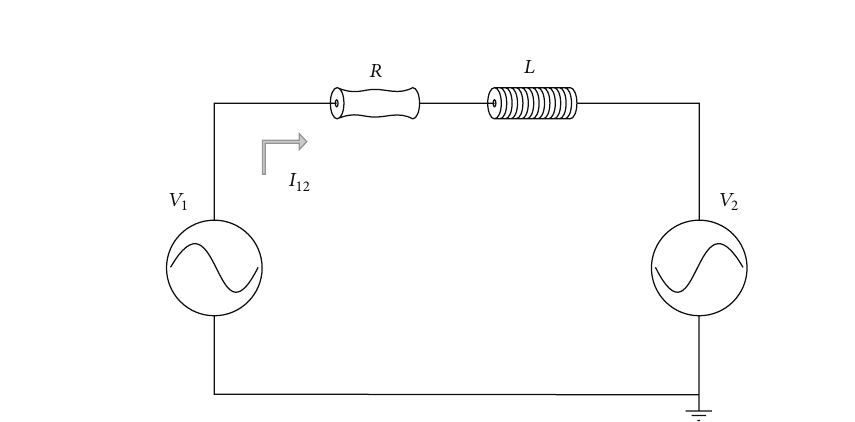
Figure 13: Power waves in the VRL StBG.